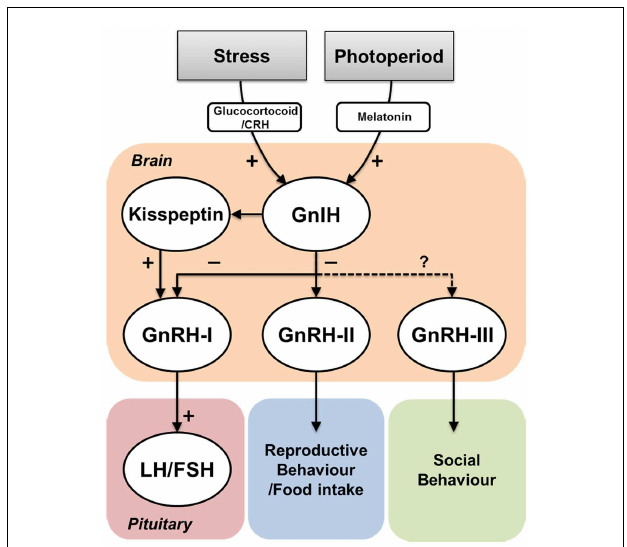
FIGURE 4 | Effect of environmental actions on GnIH system and its potential functions . Environmental cues such as social stress or seasonal/diurnal change influence on GnIH neurons via hormonal mediators such as corticosterone or melatonin. GnIH neurons negatively act on GnRH-I and GnRH-II neurons, which influence on gonadotropin (LH and FSH) secretion in the pituitary and reproductive and/or food intake behaviors, respectively. In jawless and jawed fish, GnIH neurons send projection to GnRH-III neurons, which may regulate social behaviors. In mammals, GnIH neurons are also closely associated with kisspeptin neurons. However, the role of GnIH in kisspeptin neurons remains